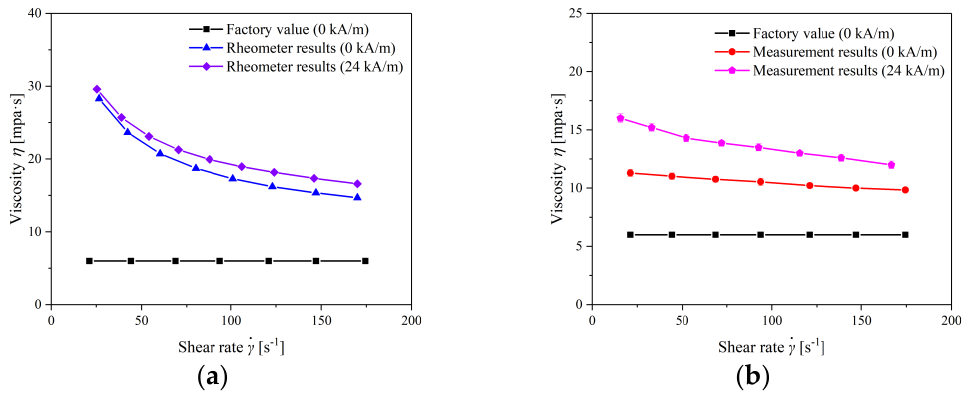
Figure 7. Comparison of commercial magnetic fluid flow curves: ( a ) rheometer measurement results of magnetic fluid under different magnetic flux densities and factory value and ( b ) novel measuring system results of magnetic fluid under different magnetic flux densities and factory value.